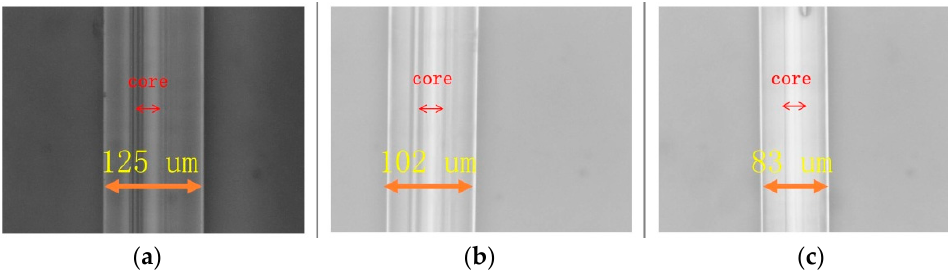
Figure 2. Microscope images of the fibers before/after etching. ( a ) Freshly prepared sample; ( b ) 3 min etching; ( c ) 7 min etching